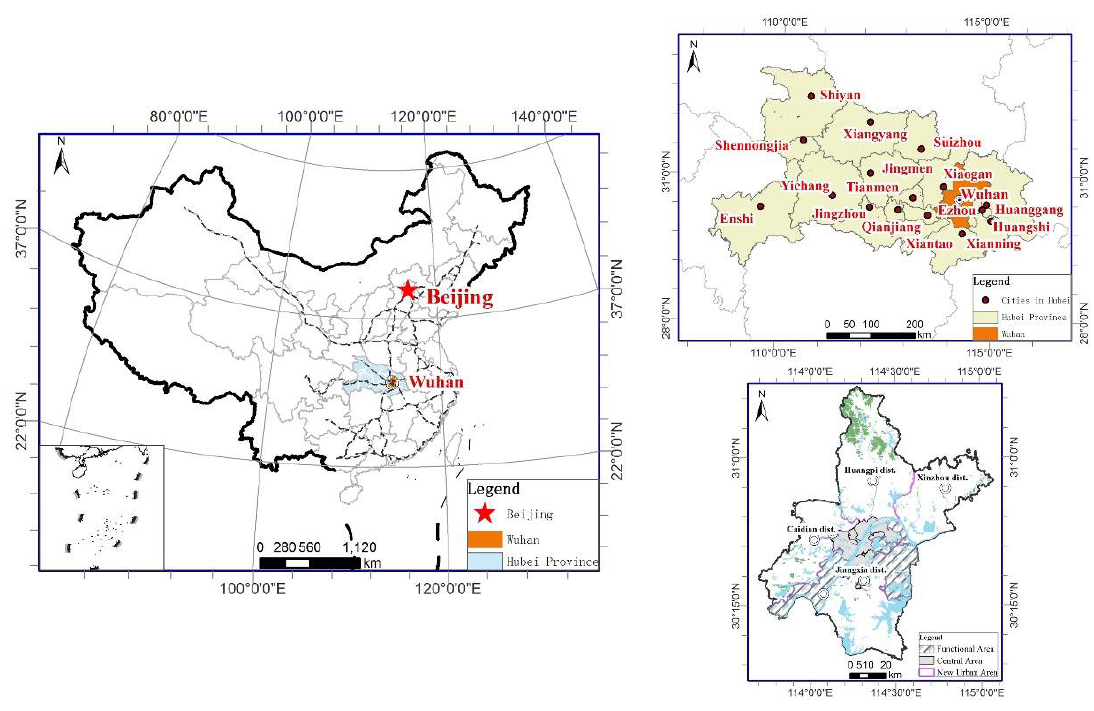
Figure 1. The location of Wuhan.